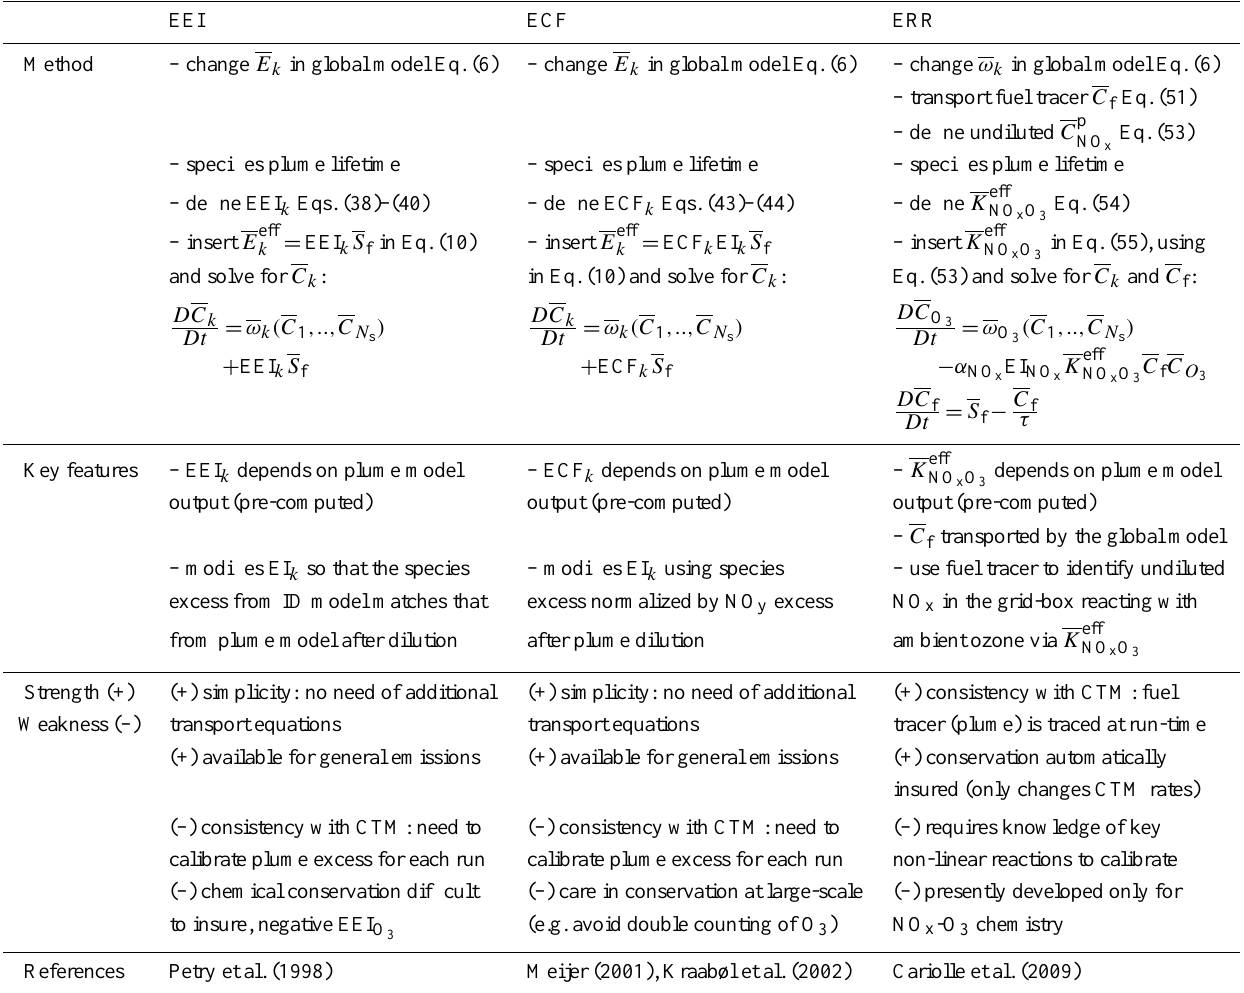
Table 3. Summary of the key features of EEI, ECF and ERR methods. EEI ECF